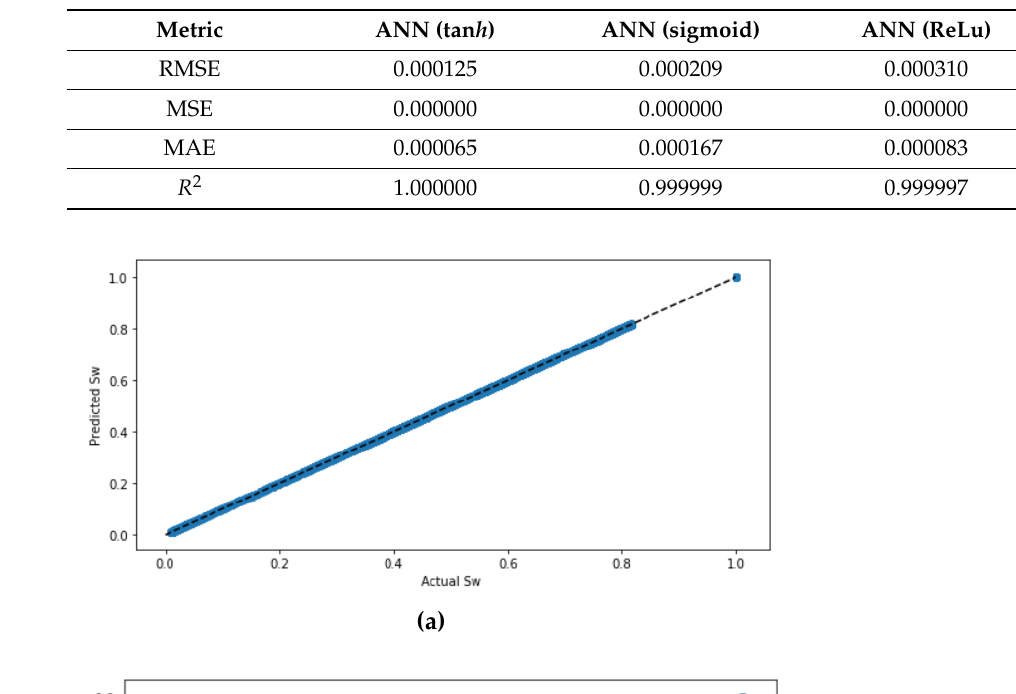
Table 6. Evaluation metric of ANN models with different activation functions for target S w .